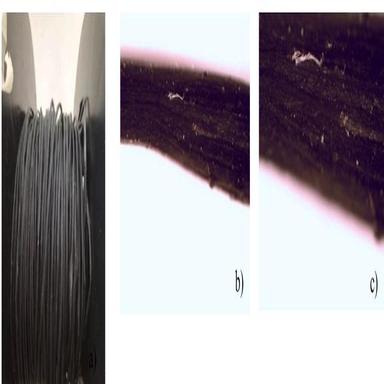
Pictures of W13 with different magnifications: a) 1x b) 20x; c) 40x.